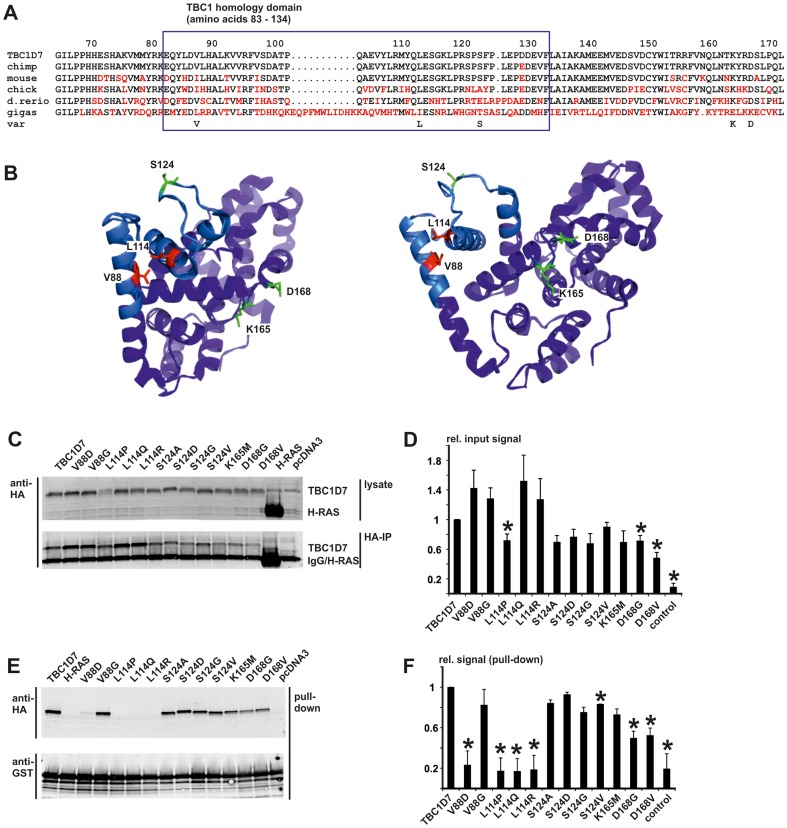
Effect of TBC1D7 amino acid substitutions on the interaction with TSC1.Interactions between TBC1D7 variants and the GST-TSC1 939–992 fusion protein were assessed by glutathione bead pull-down followed by immunoblot analysis. The TBC1D7 variants were expressed in transfected HEK 293T cells. GST TSC1 939 – 992 was expressed in E. coli and purified on glutathione-agarose beads. A. Detailed view of the evolutionary conservation of the TBC1D7 TBC homology domain. The human sequence (TBC1D7) was compared to chimpanzee (chimp), mouse, chicken (chick), zebrafish (d.rerio) and fruit fly (gigas). Non-identical residues are highlighted in red. Variant amino acids (var) tested for their effect on the binding with TSC1 are indicated below the alignment. B. Structural representation of TBC1D7 as determined by X-ray crystallography. The TBC homology domain is indicated by the light-blue shading. The positions of amino acids V88 and L114 are indicated in red; amino acids S124, K165 and D168 are shown in green. C. Immunoblot analysis of TBC1D7 variants. Expression (upper panel) and immunoprecipitation (lower panel) of the HA-tagged TBC1D7 variants was compared to the wild-type protein (TBC1D7), HA-tagged H-RAS (H-RAS) and mock-transfected cells (pcDNA3). D. The integrated intensities of the immunoblot signals of the expressed TBC1D7 variants were quantified relative to the wild-type protein (TBC1D7 = 1) in at least 3 independent experiments. Significant differences (paired t-test p values<0.05) are indicated with asterisks. Error bars indicate the standard error of the mean. E. Immunoblot analysis to show retention of the TBC1D7 variants (upper panel) by glutathione beads bound to the GST-TSC1 939–992 fusion protein (lower panel). F. The integrated intensities of the immunoblot signals of the TBC1D7 variants retained on the glutathione beads were quantified relative to the wild-type protein (TBC1D7 = 1) in at least 3 independent experiments. Significant differences (paired t-test p values<0.05) are indicated with asterisks. Error bars indicate the standard error of the mean.